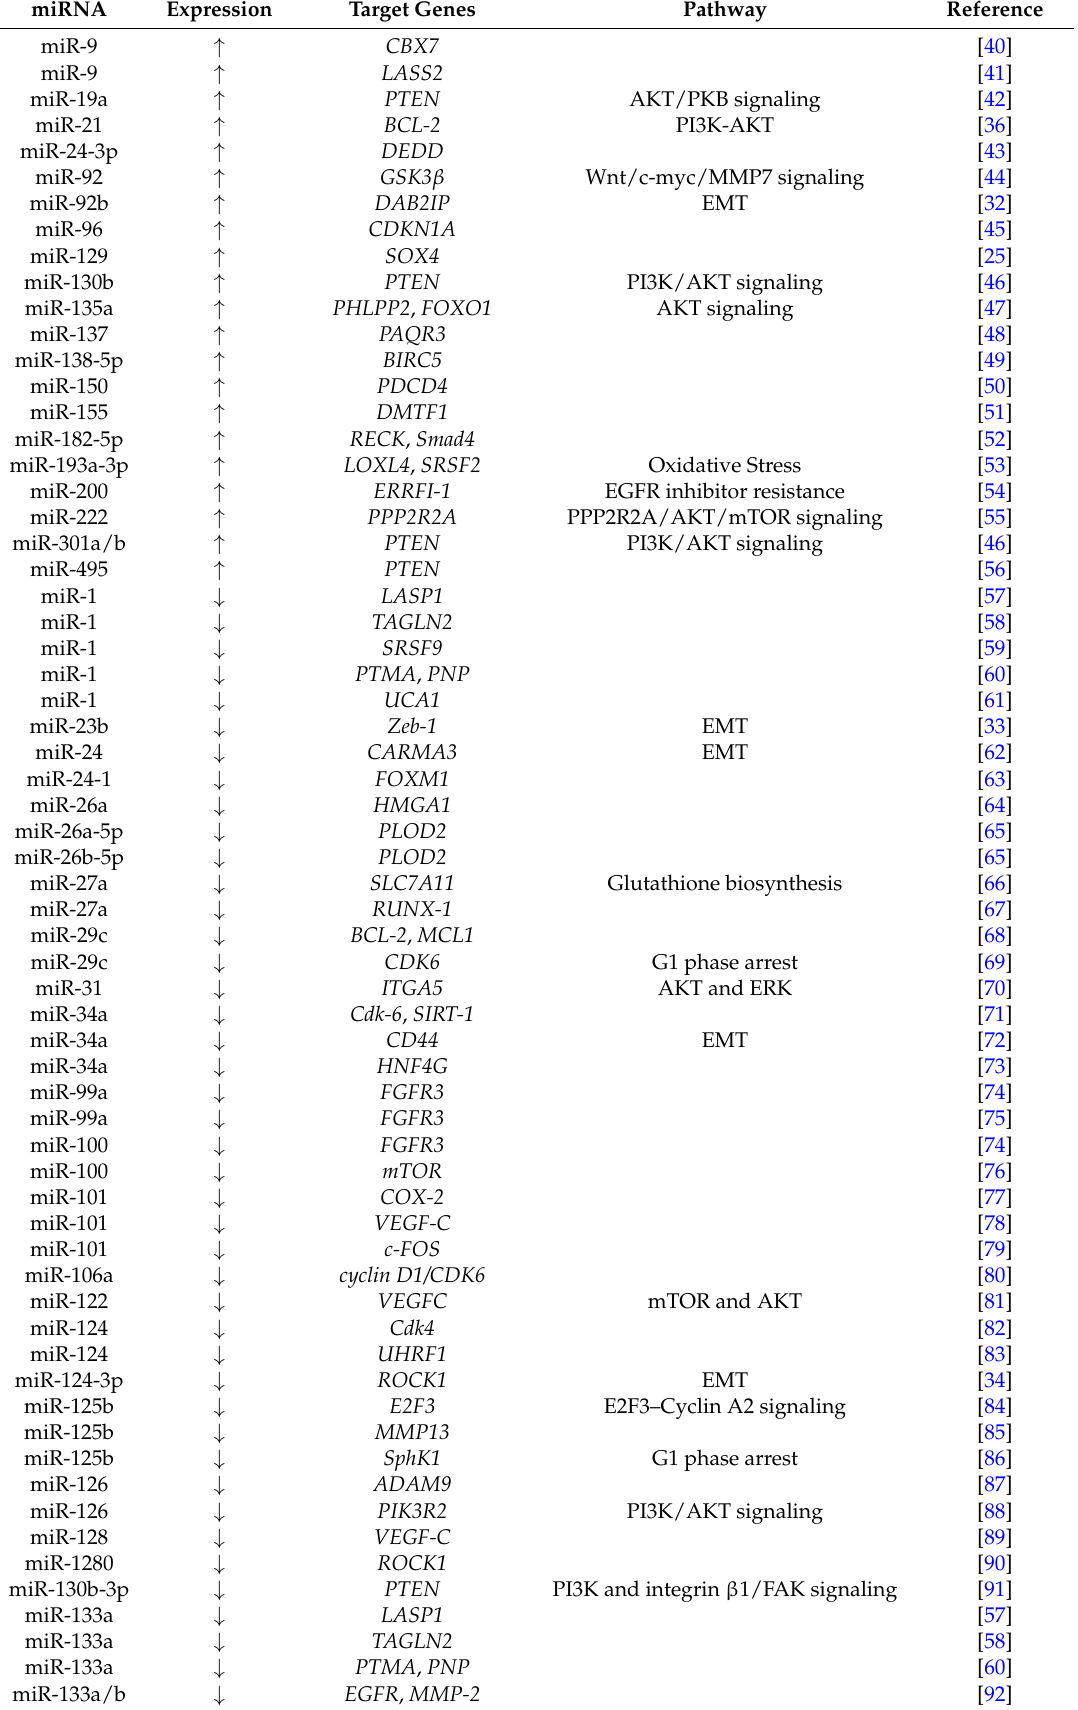
Table 1. Studies reporting the validated target genes for miRNAs in bladder cancer cells.